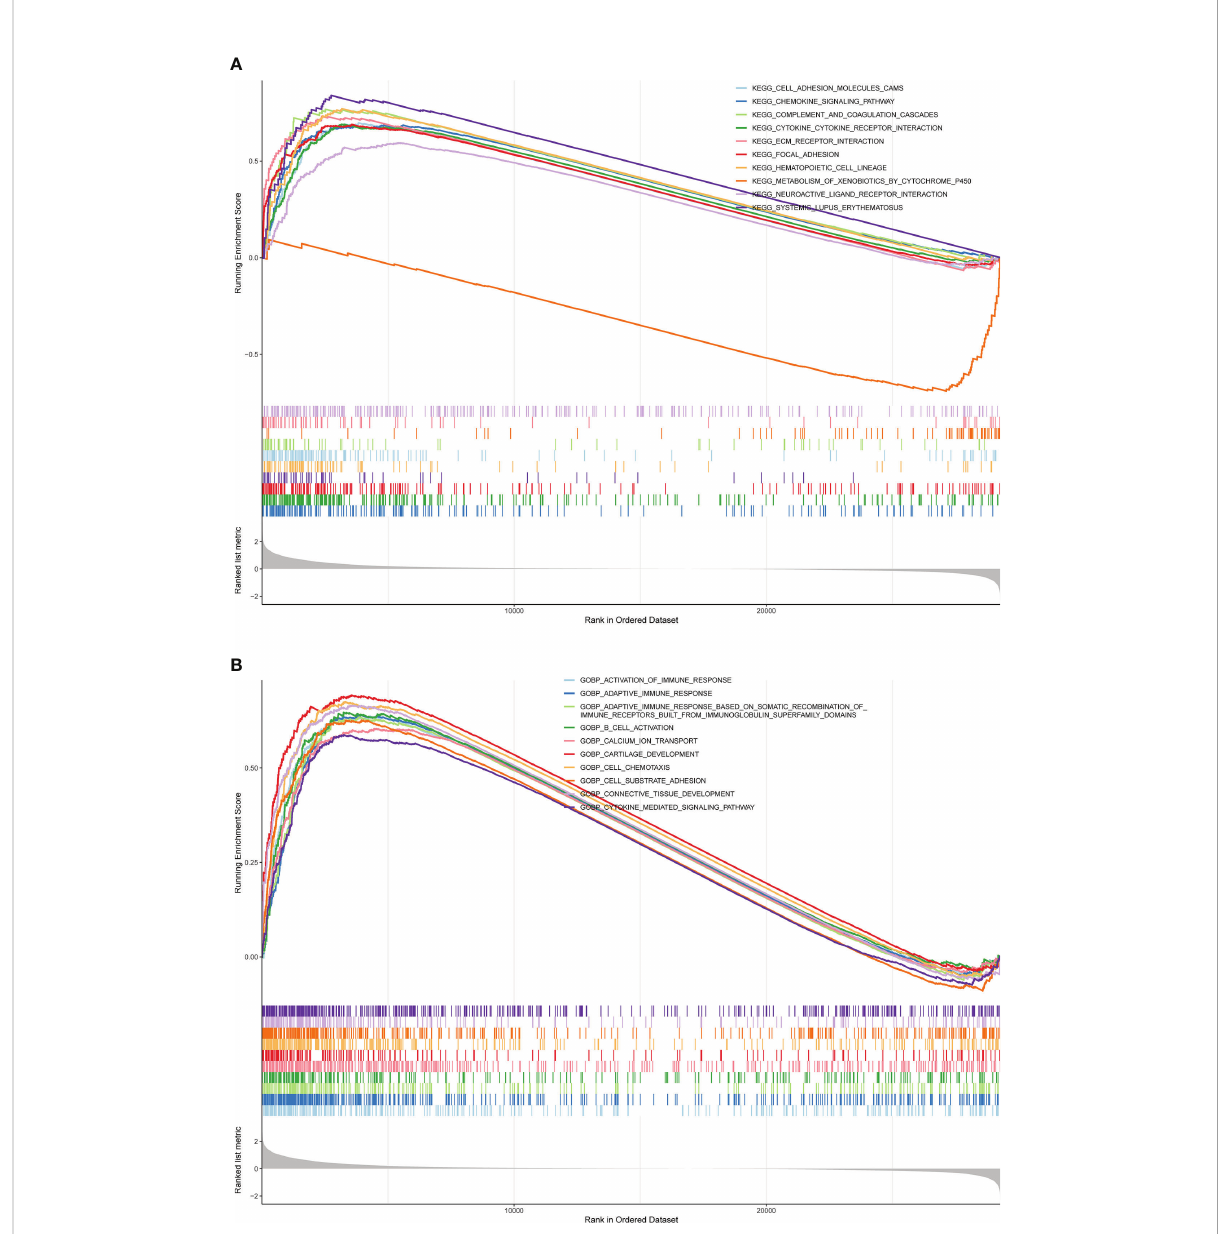
FIGURE 5 GSEA is adopted to annotate the genes with different expression in the terms of GO and KEGG between different risk groups. (A) Top 10 KEGG pathways. (B) Top 10 GO